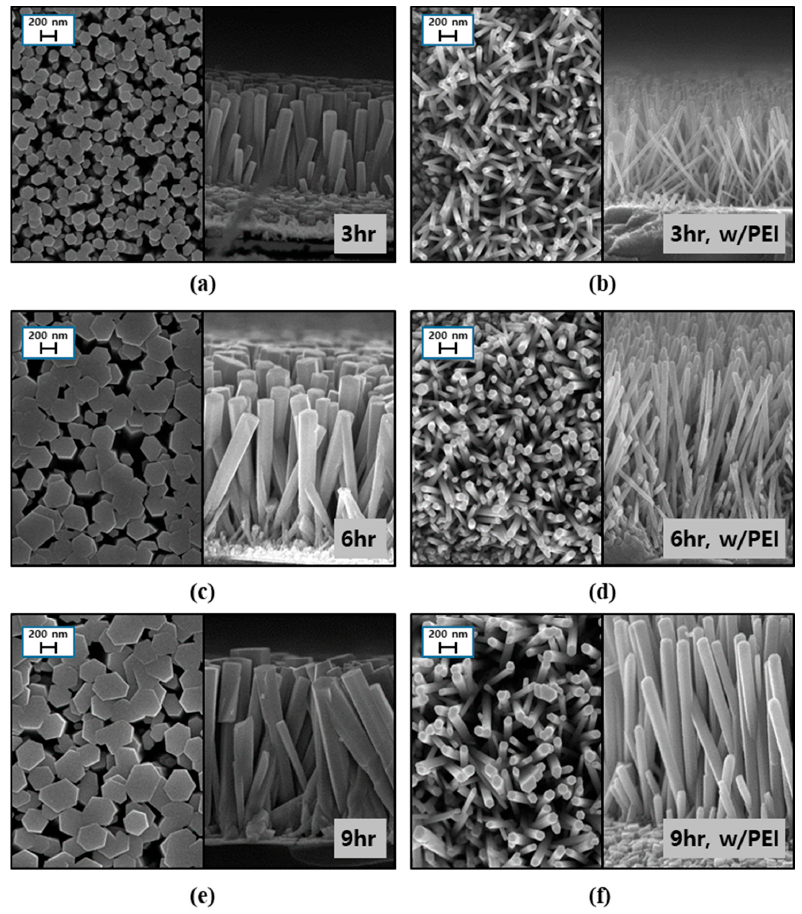
Figure 4. HR FE-SEM images of ZNRs prepared with various growth times at 90 ◦ C ( a , c , e ); no polyethylenimine (PEI) and ( b , d , f ); PEI added to precursor solutions. ZNR growth behaviors depending on the presence of PEI are compared in Figure 5.